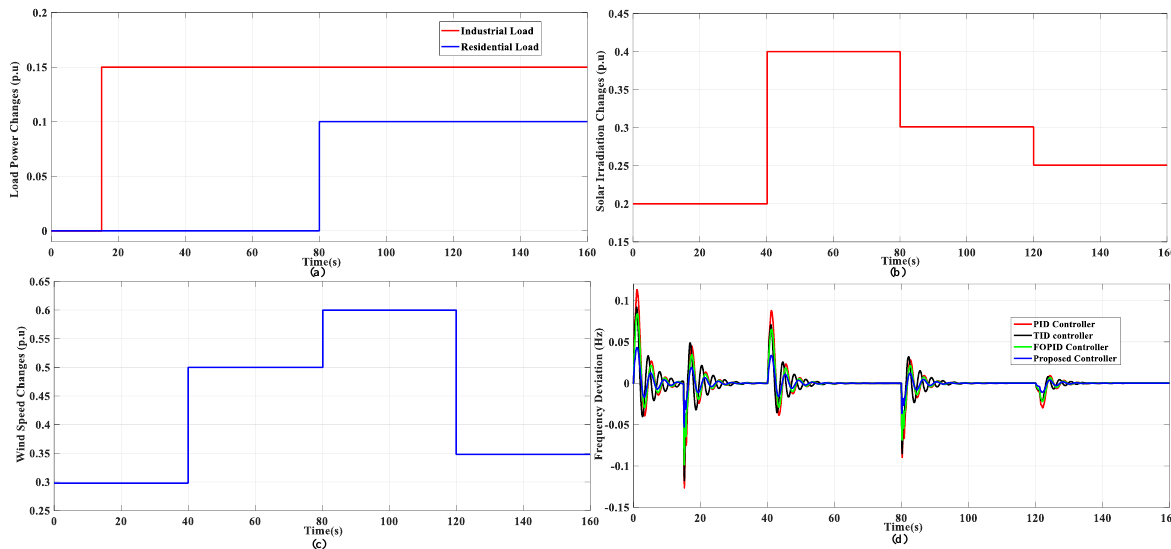
Figure 5. Perturbations and simulation result for scenario 1. ( a ) Load disturbances. ( b ) Wind speed changes. ( c ) Solar irradiation changes. ( d ) Obtained frequency responses. Table 3. ITAE and ISE performance criteria of the MG frequency deviation employing different controllers.